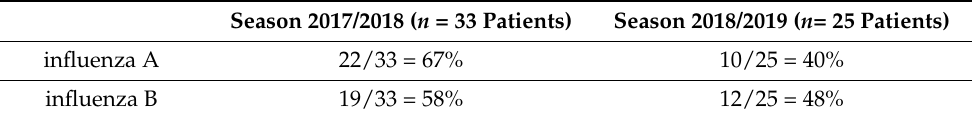
Table 4. Seroconversion rate of the influenza vaccine among study group patients during both influenza